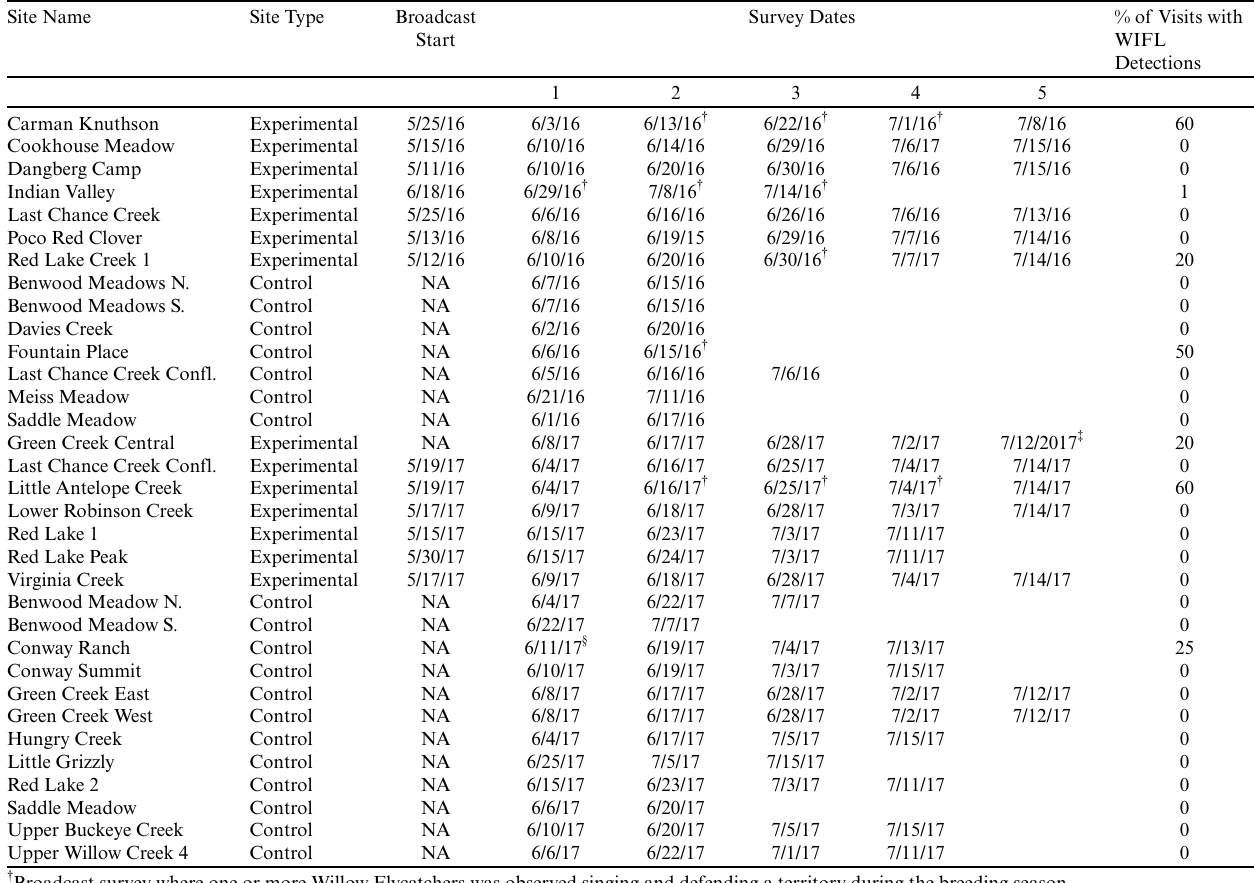
Table 1 . Experimental (with conspecific broadcast) and control (without conspecific broadcast) meadows surveyed for Willow Flycatchers ( Empidonax traillii ) in 2016 or